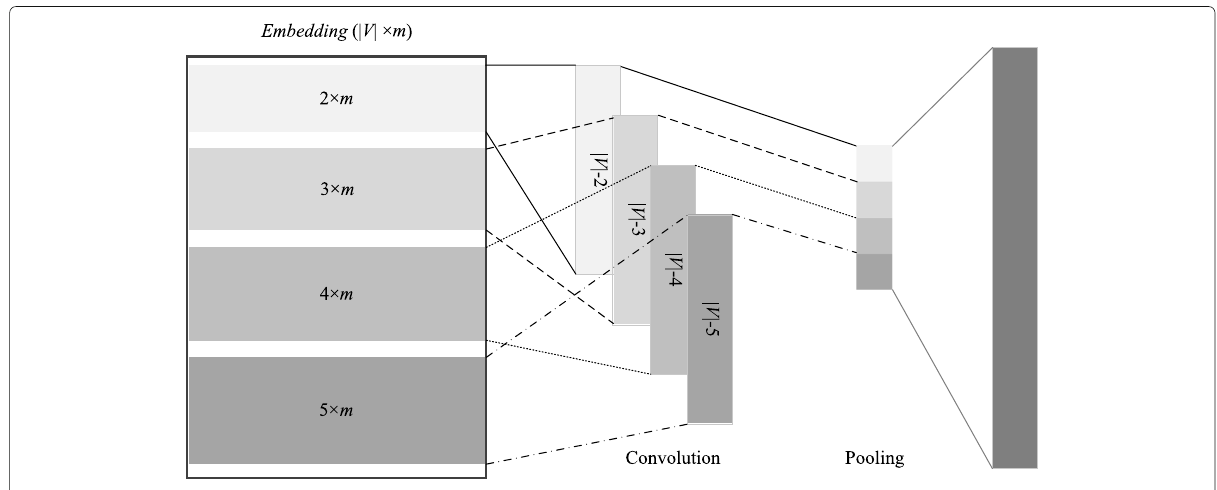
Fig. 3 The process of convolution and max-pooling in the system call intrusion-detection model (cid:3) (cid:3) (cid:5)(cid:5) f = ReLU conv embedding ( x )